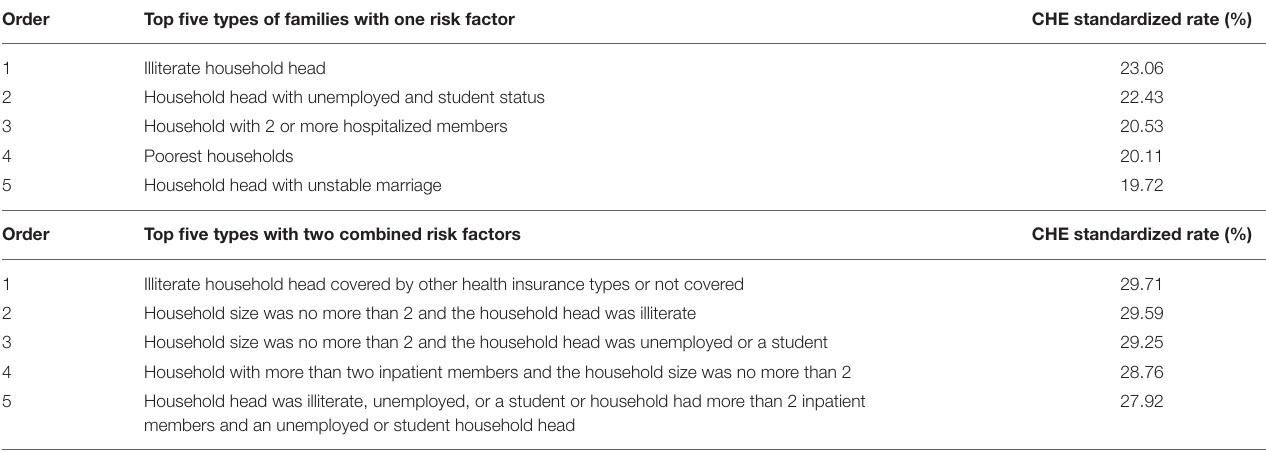
TABLE 5 | Top 5 family characteristics related to CHE with a single risk factor and two combined CHE risk factors. Order